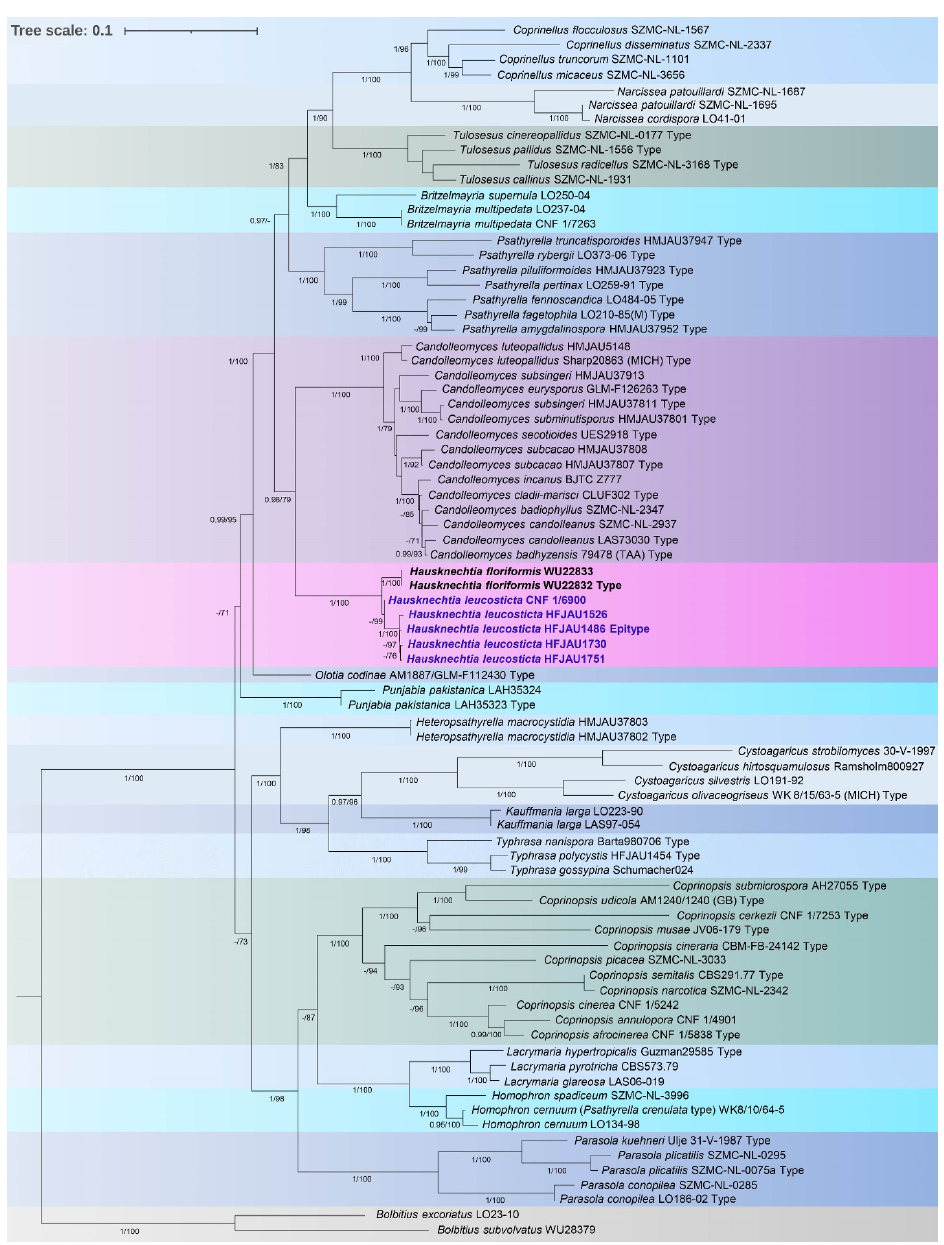
Figure 1. Concatenated phylogenetic tree of Psathyrellaceae species based on Bayesian interference (BI) and Maximum Likelihood (ML) analyses of four-gene (ITS, LSU, tef-1 α , β -tub) sequence alignment. BI and ML analyses were performed using MrBayes v. 3.2.6 and IQ-TREE 1.6.12, respectively. Significant branch support values, Bayesian posterior probability (BI-PP ≥ 0.95) and ultrafast bootstrap support (ML-BP ≥ 70%), are presented at the nodes. Species with newly generated sequences are marked in bold and recombined species is marked in colour and